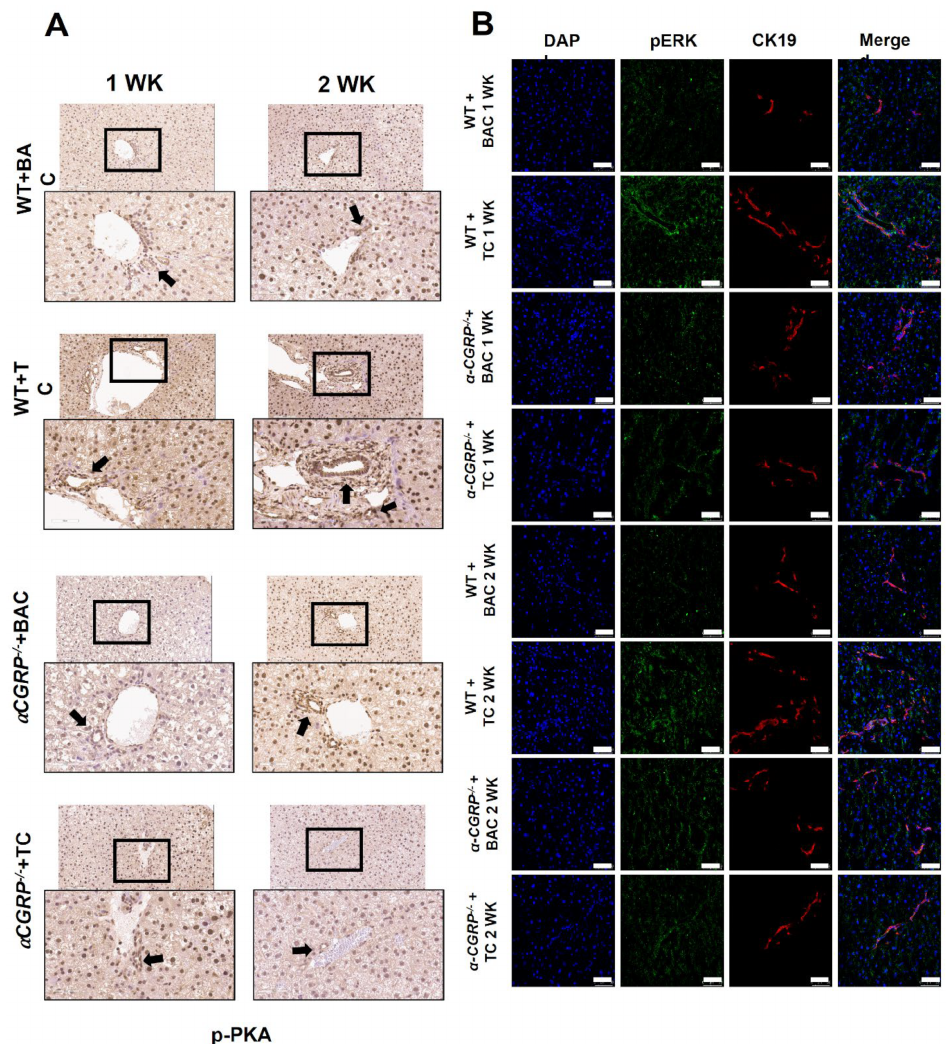
Figure 7. Phospho-PKA and phospho-ERK immunoreactivity is reduced in α -CGRP − / − mice fed TC diet. ( A ) Immunohistochemistry of phospho-PKA in paraffin-embedded liver sections, and ( B ) im- munofluorescence for phospho-ERK (green) co-stained with CK19 (red, marker of cholangiocytes, original magnification 40 × ; scale Bar 50 µ m) in frozen liver sections from the selected groups of mice. Biliary immunoreactivity for phospho-PKA and phospho-ERK increased in liver sections from TC-fed α -CGRP − / − mice fed TC compared to α -CGRP − / − mice fed BAC. Original magnification 20 × ; scale bar 100 µ m. Black box: original magnification 40 × , scale bar 50 µ